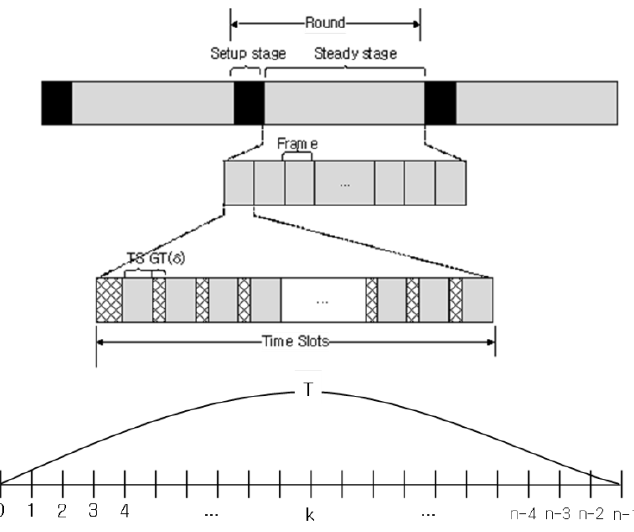
Figure 8. TDMA-based data